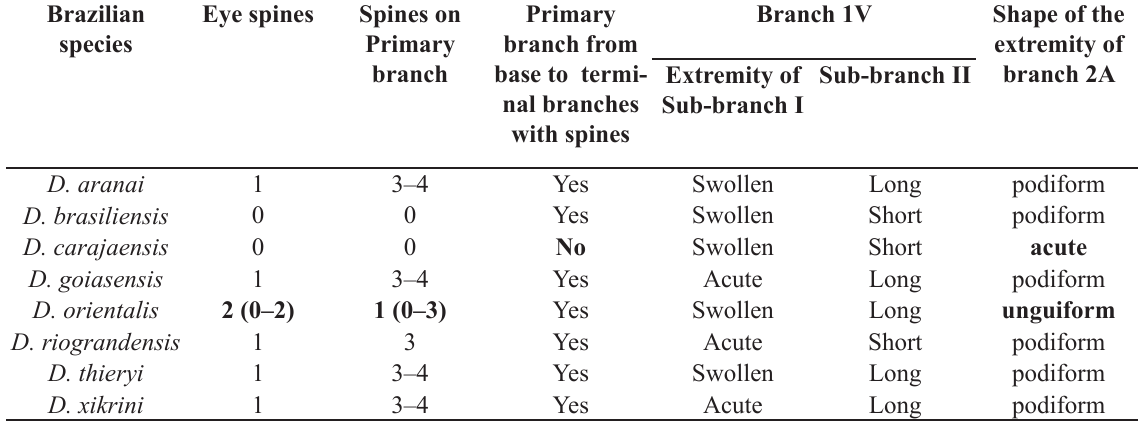
Table 1. Cephalic richness in Brazilian Dendrocephalus Daday, 1908. The bold characters correspond to characters allowing a direct determination of species in Brazil. Sub-branch II is indicated as short when it was less than half of sub-branch